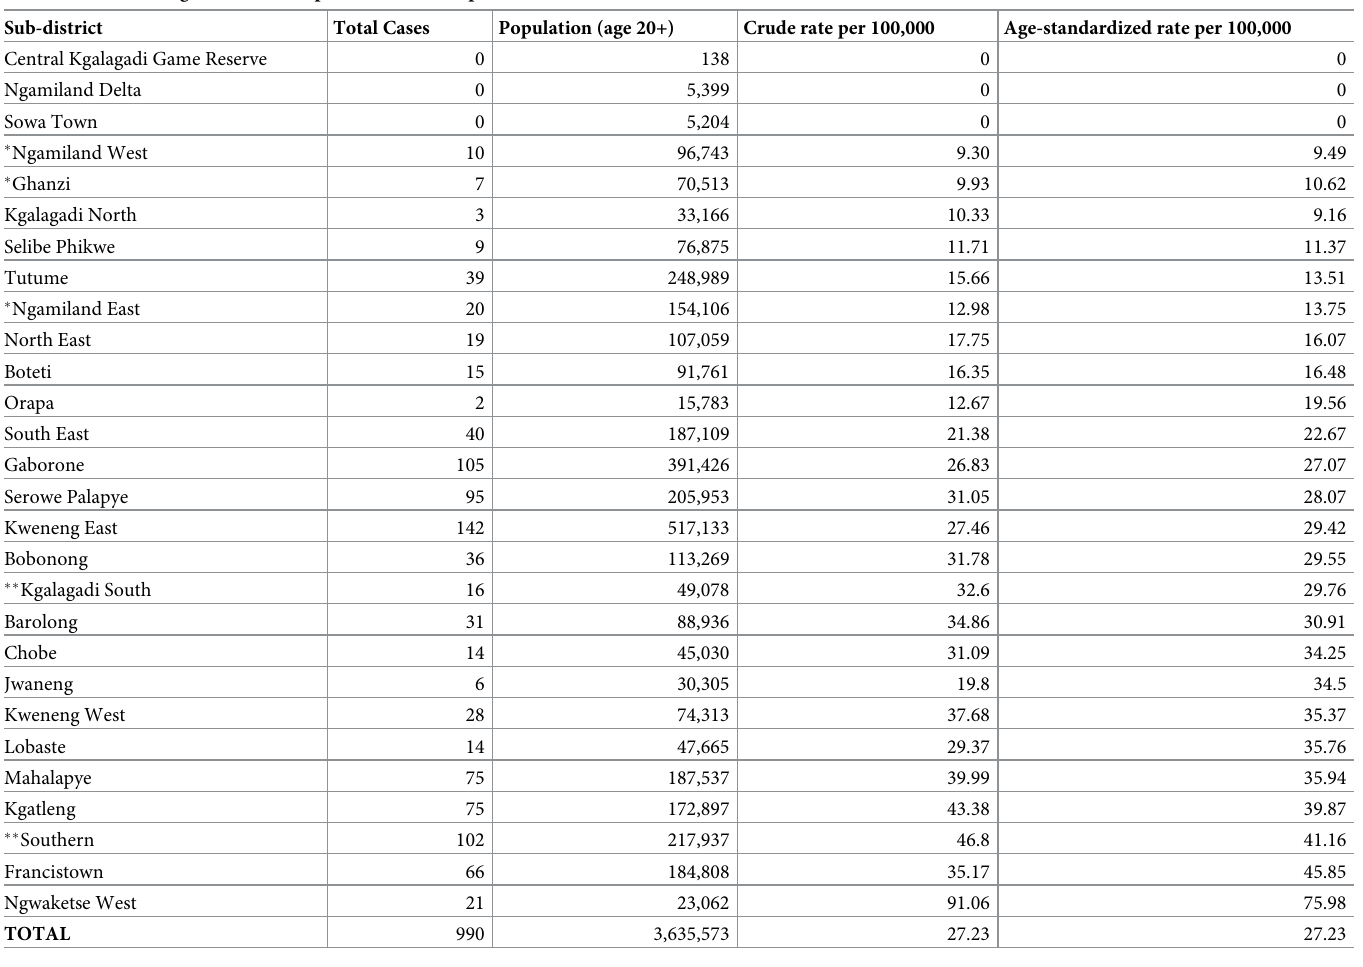
Table 2. Crude and age standardized presentation rates per 100,000